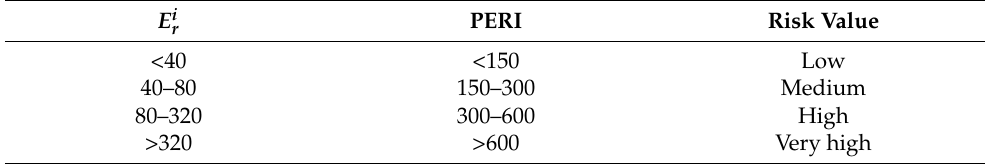
Table 5. PERI indicator classification